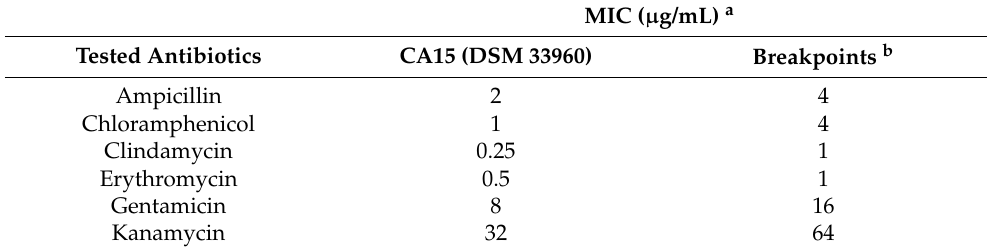
Table 1. Safety properties of the L. rhamnosus CA15 (DSM 33960)